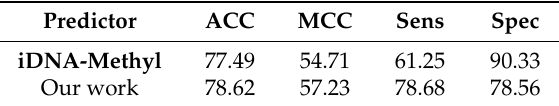
Table 5. Comparison with iDNA-Methyl .